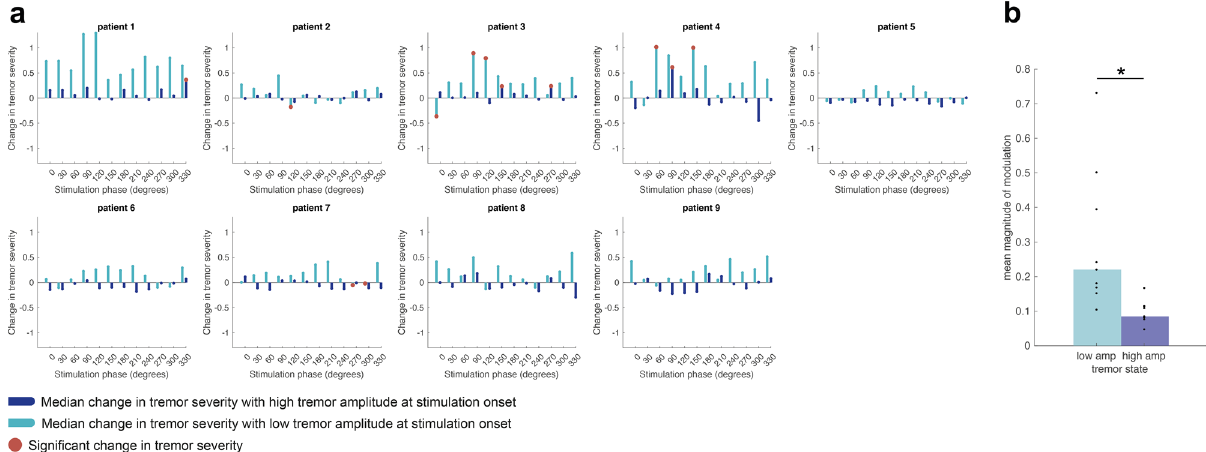
Figure 3. Individual stimulation effects during low and high tremor amplitude. ( a ) Shows individual amplitude response curves after dividing the data according to the tremor amplitude during the second prior to stimulation onset. Data are shown for the dominant (tracked) axis. Light blue bars corresponding to ARCs computed from stimulation blocks where tremor amplitude prior to stimulation was below the median tremor amplitude across the stimulation condition and dark blue bars where tremor amplitude prior to stimulation was above the median. Red dots indicate the phases at which stimulation induced a change in tremor severity significantly different to that observed naturally during similarly analysed unstimulated data. ( b ) Indicates that the mean absolute effect size obtained by peripheral stimulation when delivered at spontaneously low tremor amplitude epochs (light blue) is significantly higher than when delivered at high tremor amplitude epochs (dark blue) ( p =